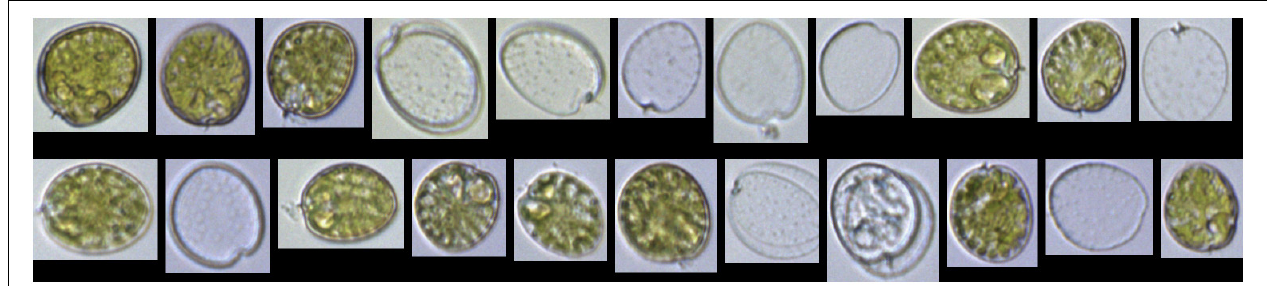
FIGURE 3 | FlowCam collage of P. concavum , which illustrates that even an exponentially growing laboratory culture contains both live cells and accumulated, empty thecae.